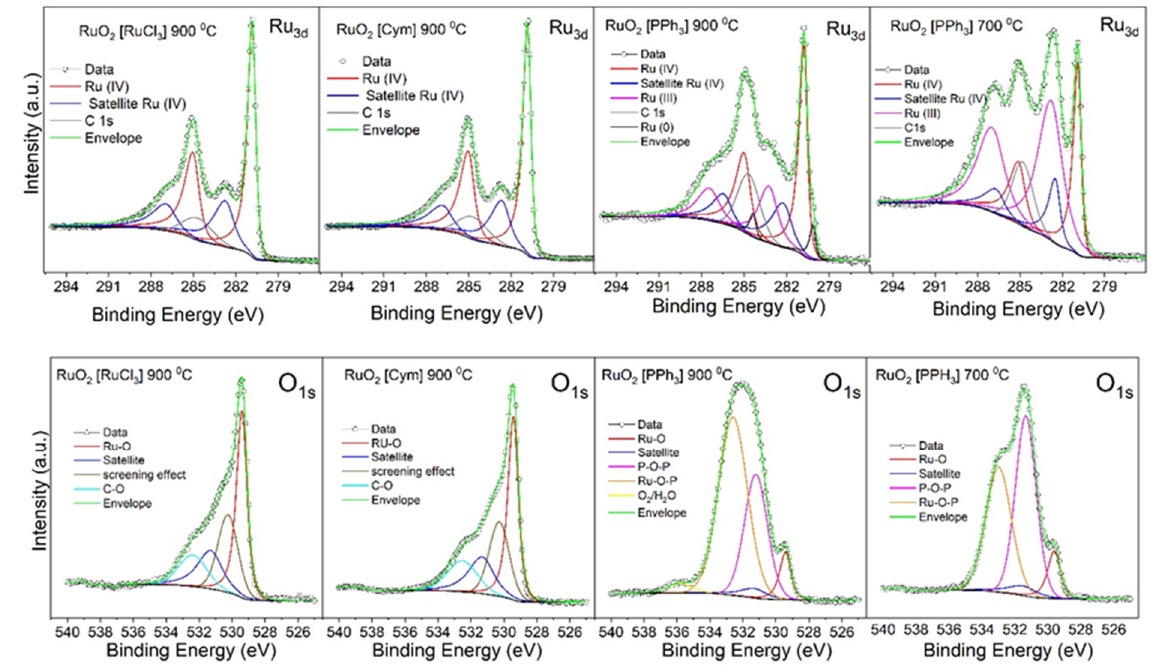
Figure 5. Ru3d and O1s spectra for the RuO 2 [RuCl 3 ], RuO 2 [Cym], and RuO 2 [PPh 3 ] materials cal- cined at 900 °C and the RuO 2 [PPh 3 ] obtained at 700 °C.